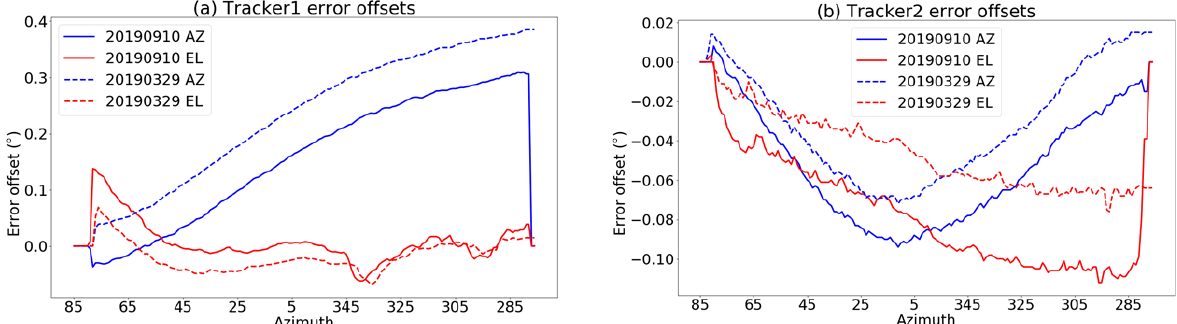
Figure 12. Error offsets of Tracker1 (a) and Tracker2 (b) 6 months apart. Blue lines plot azimuth (AZ) offsets, and red lines show elevation (EL)